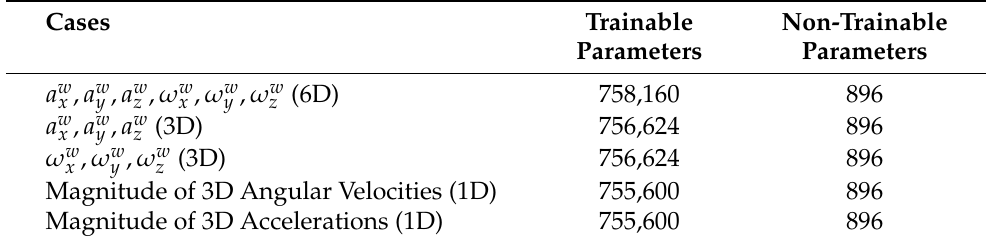
Table 4. Comparison of trainable and non-trainable parameters for different cases of multi- emotion classification.